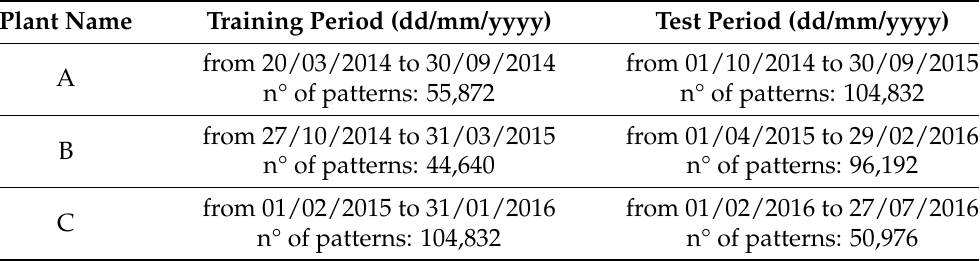
Table 3. Temporal extension of the data-sets and data used for training and for testing for each PV plant. The number of measured patterns is also shown (patterns are 10 dimensional for plants A and B, and 11 dimensional for plant